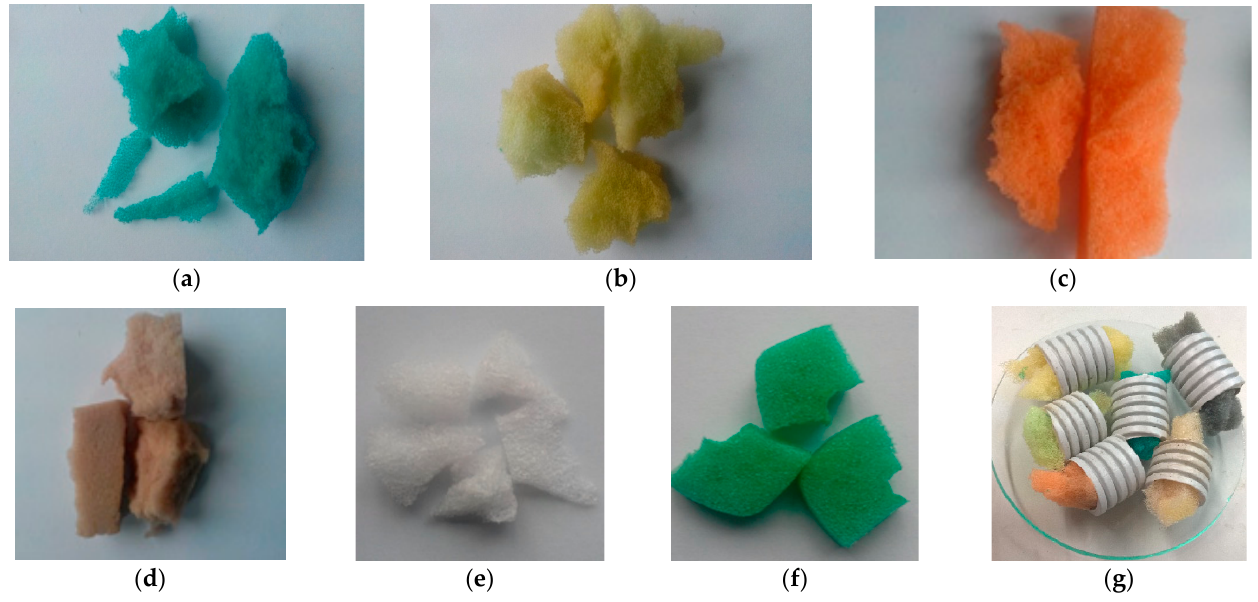
Figure 1. Biomass carriers used in the study, ( a – d ) group I, i.e., porous flexible foams, ( e – f ) group II, i.e., rigid foams with closed pores, ( g ) group III, i.e., porous elastic foams placed in a